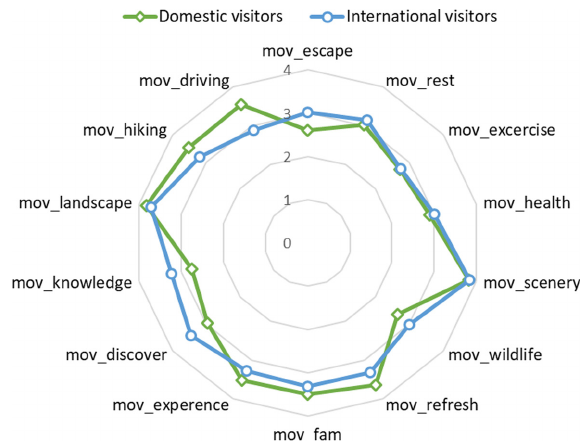
Fig. 3. Mean scores of push- and pull-factor motivations between domestic and international visitors. Source: own study.